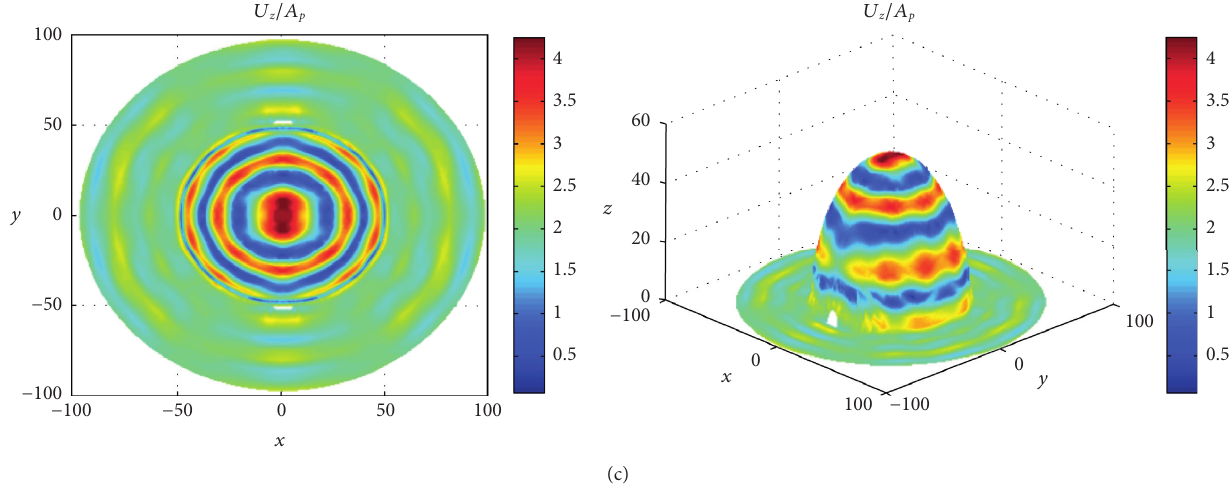
Figure 6: Surface displacement amplitude of the 3D tunnel mountain under the incident P wave ( η � 5 . 0 , α � 0 ° ): (a) surface displacement amplitude in x direction; (b) surface displacement amplitude in y direction; (c) surface displacement amplitude in z